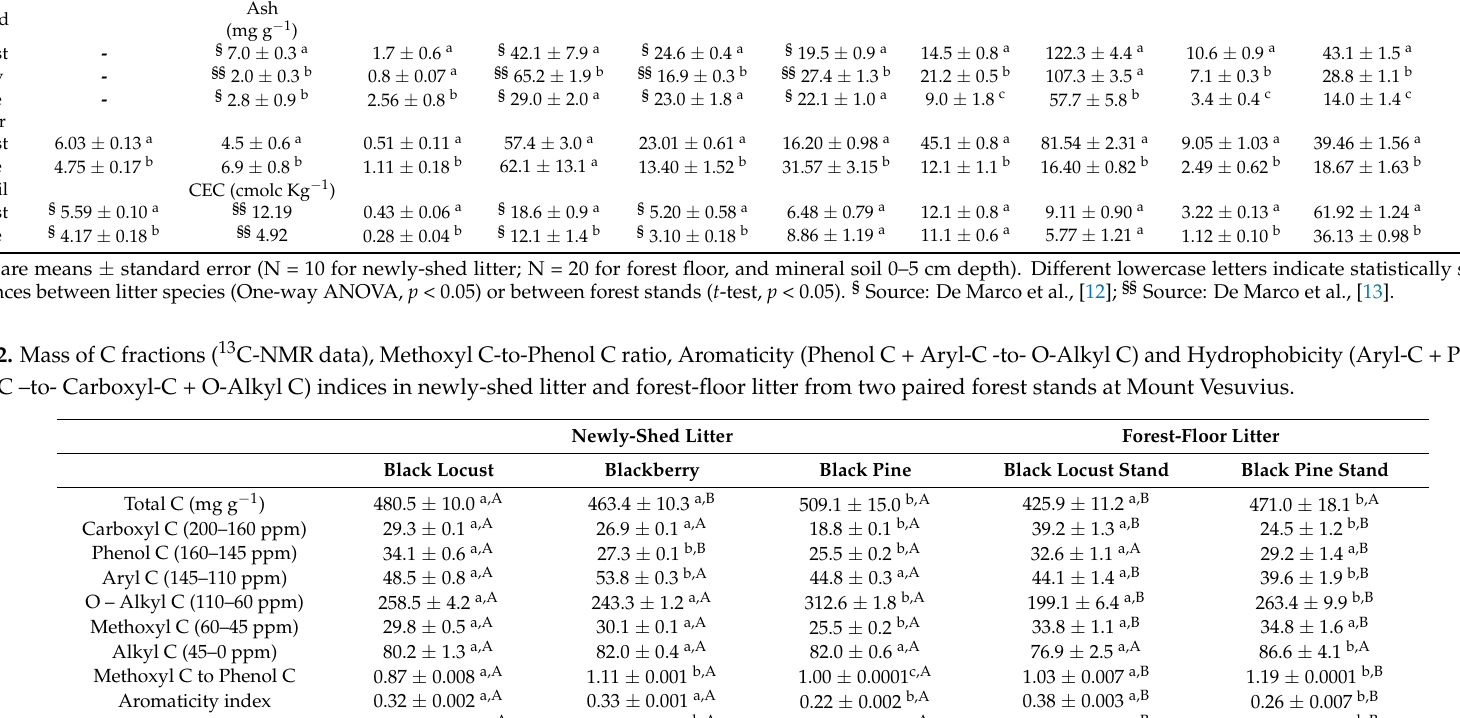
Table 1. Main characteristics of newly-shed litters, forest-floor litter and mineral soil of paired stands of black locust ( Robinia pseudoacacia) and black pine ( Pinus nigra ) at Mount Vesuvius. pH-H 2 O Ash/CEC P Mn N C-to-N N-to-P Soluble C Soluble N Soluble N Soluble C-to-N Ash Newly-shed (mg g − 1 ) Black locust